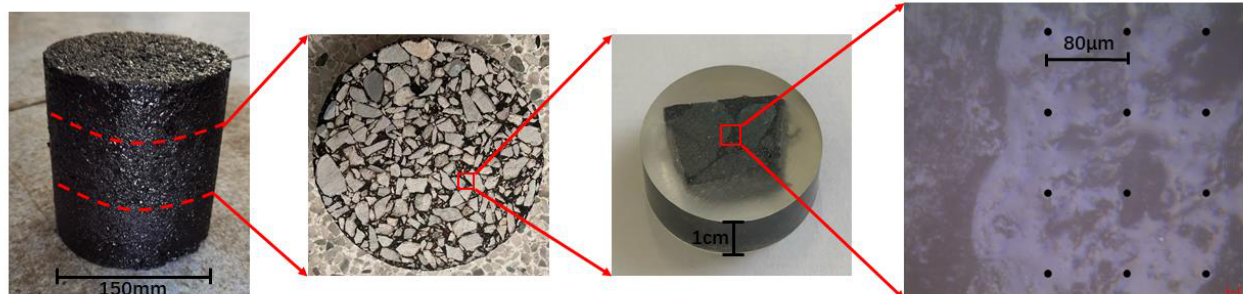
Figure 2. Preparation of nanoindentation specimens.